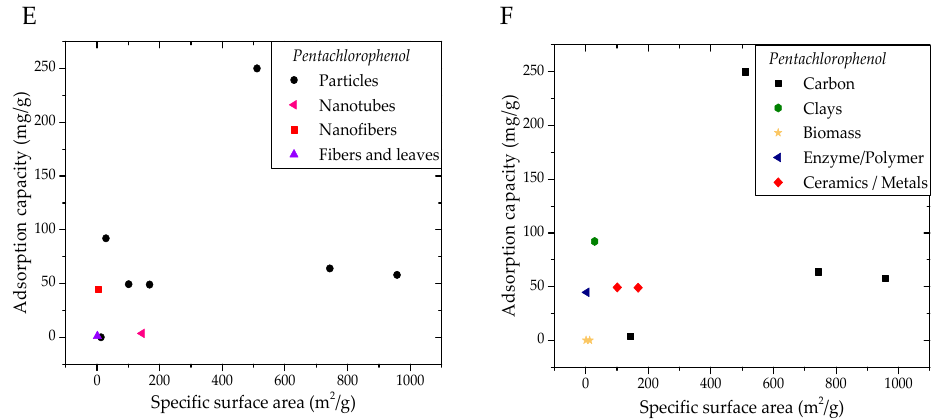
Figure 5. Adsorption capacity related to adsorbent specific surface area for different adsorptive structures and different adsorbent compositions against Phenol ( A , B ); 2-Chlorophenol ( C , D ) and Pentachlorophenol ( E , F ).